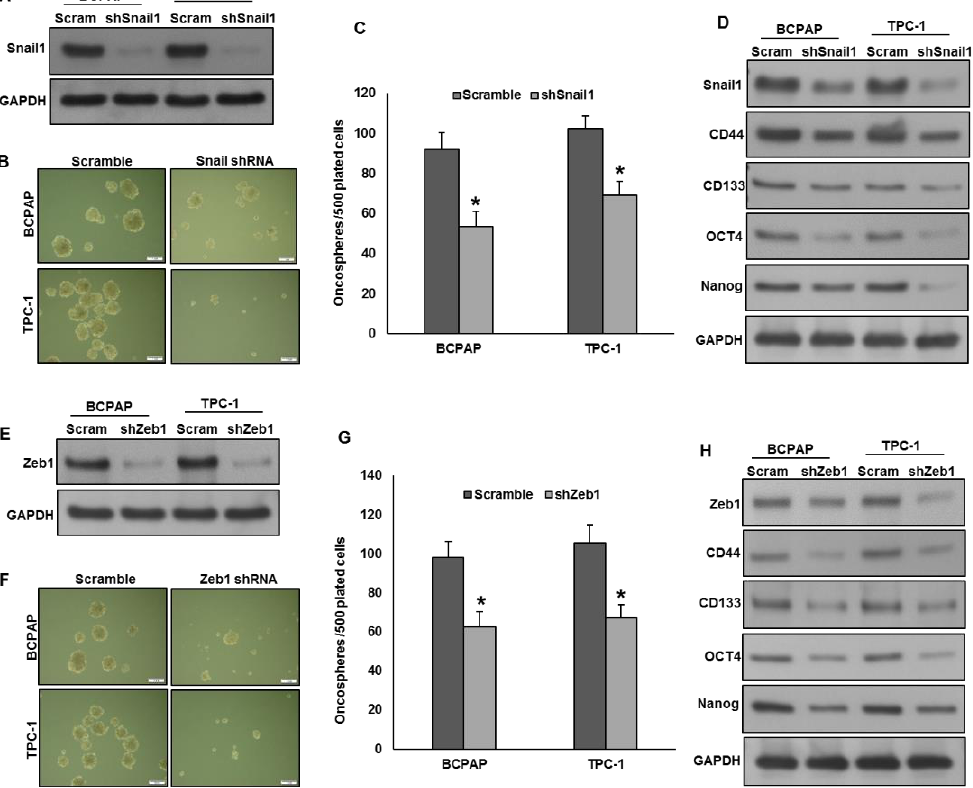
Figure 6. Silencing of Snail1 and Zeb1 suppresses self-renewal ability of spheroids generated from PTC cells. ( A ) Knockdown of Snail1. PTC cells were transfected with Snail1 shRNA and knockdown was confirmed by immunoblotting. ( B , C ) Silencing of Snail1 suppresses spheroid growth. PTC cells were transfected with Snail1 shRNA and cells were subjected to sphere forming assay. Spheroids in the entire dish was counted. (Scale bars, 1 mm). ( D ) Silencing of Snail1 reduces stemness of spheroids. PTC cells were transfected with Snail1 shRNA and grown in sphere medium. Proteins were isolated from spheroids and immunoblotted with antibodies against Snail1, CD44, CD133, OCT4, NANOG and GAPDH. ( E ) Knockdown of Zeb1. PTC cells were transfected with Zeb1 shRNA and knockdown was confirmed by immunoblotting. ( F , G ) Silencing of Zeb1 suppresses spheroid growth. PTC cells were transfected with Zeb1 shRNA and cells were subjected to sphere forming assay. Spheroids in the entire dish was counted. (Scale bars, 1 mm). ( H ) Silencing of Zeb1 reduces stemness of spheroids. PTC cells were transfected with Zeb1 shRNA and grown in sphere medium. Proteins were isolated from spheroids and immunoblotted with antibodies against Zeb1, CD44, CD133, OCT4, NANOG and GAPDH. Data presented in the bar graphs are the mean ± SD of two independent experiments. * Indicates a statistically significant difference compared to control with p < 0.05.